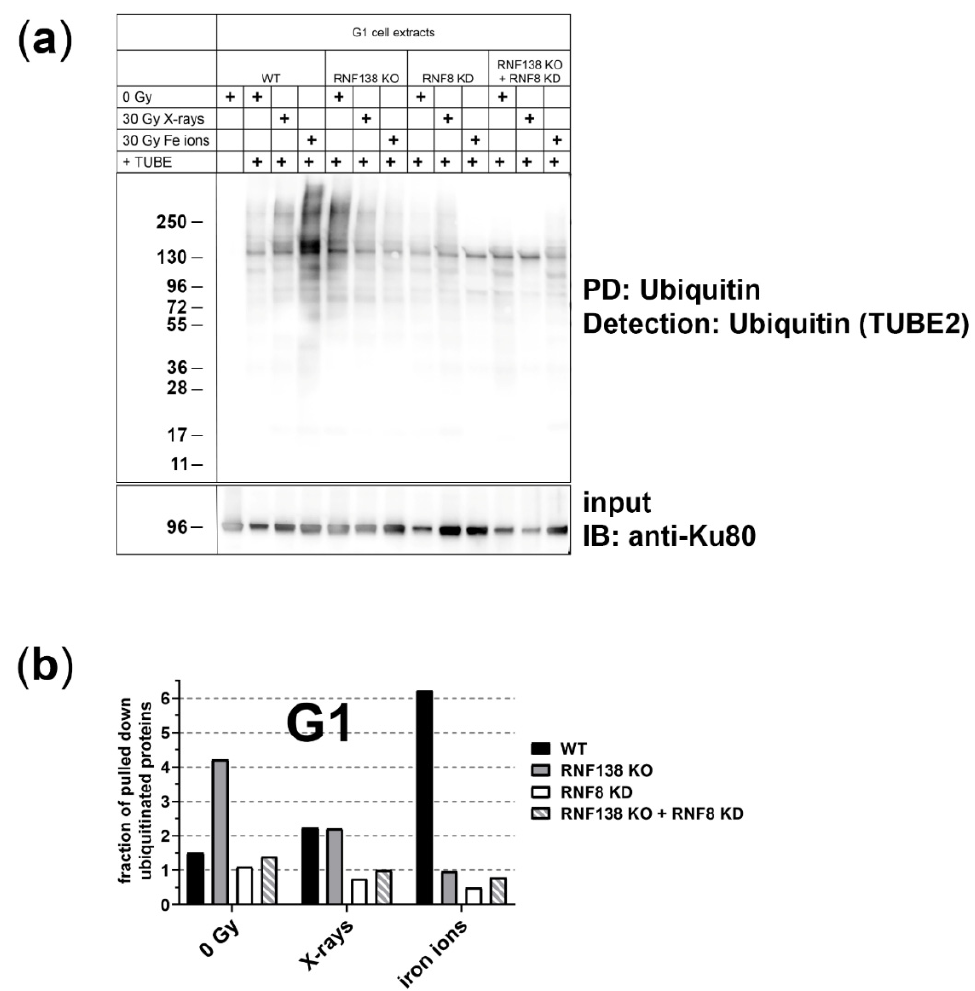
Figure 2. Protein-pulldown experiments point out that the E3 ubiquitin ligases RNF8 and RNF138 are required for radiation-related ubiquitination in G1 cells . ( a ) HeLa.S-Fucci cells proficient (wt) or deficient for RNF138 (RNF138 KO) and/or RNF8 (RNF8 KD) were irradiated either with 30 Gy X-rays or 30 Gy high-energy iron ions. 1 h after irradiation G1 cells were isolated via flow cytometry, their proteins extracted, and ubiquitinated proteins pulled down and visualized with TUBE2. PD: pull down; IB: immunoblot. ( b ) For quantification of ubiquitinated proteins, western-blot detection of Ku80 in the input-protein extracts (whole-cell extracts that were used for PD, see ( a ) was used for normalization to equal loading. For all conditions, the extracts for the pull-down reactions were performed from 10 6 cells each. Differences in the protein concentration of these extracts are based on the success of cell lysis and reflected in the Ku80 signal. n = 1.